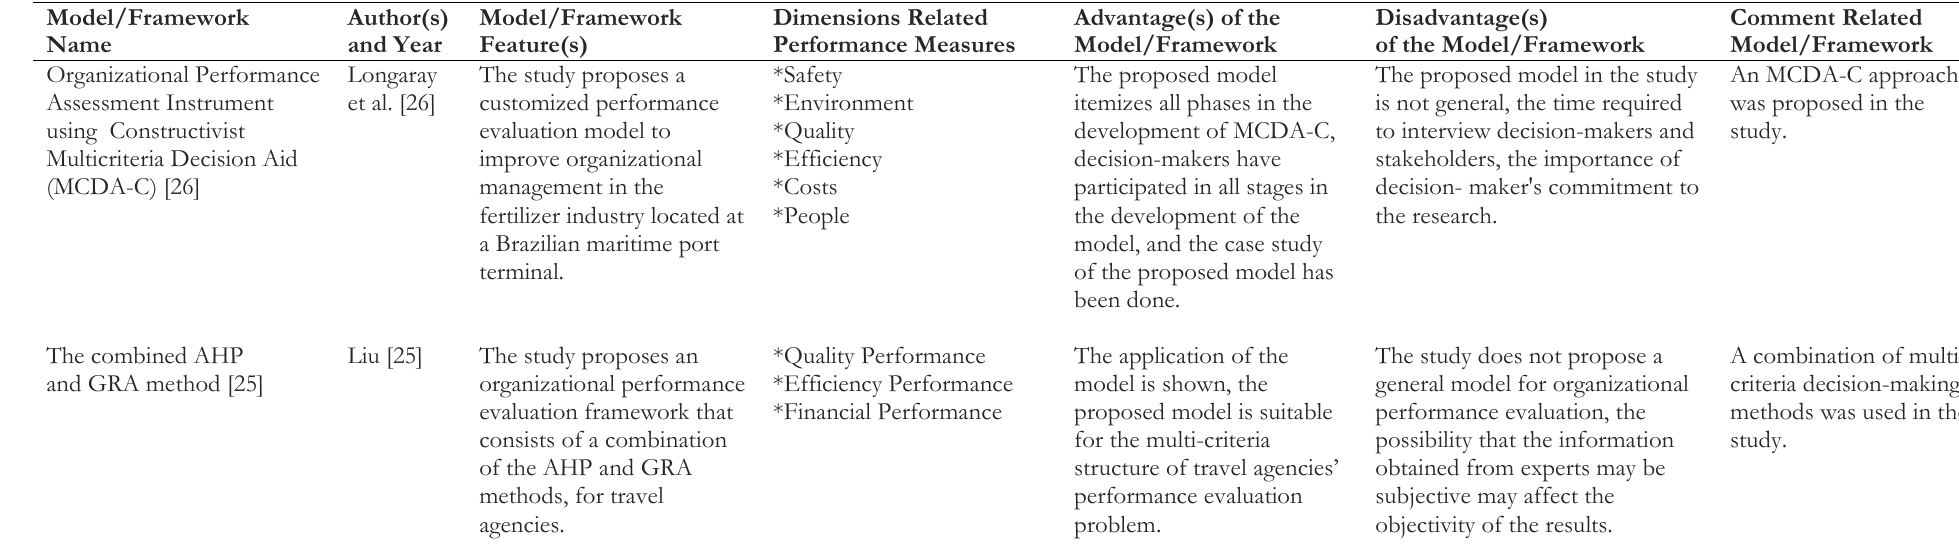
Table 7. Organizational performance measurement models developed in Industry 4.0.